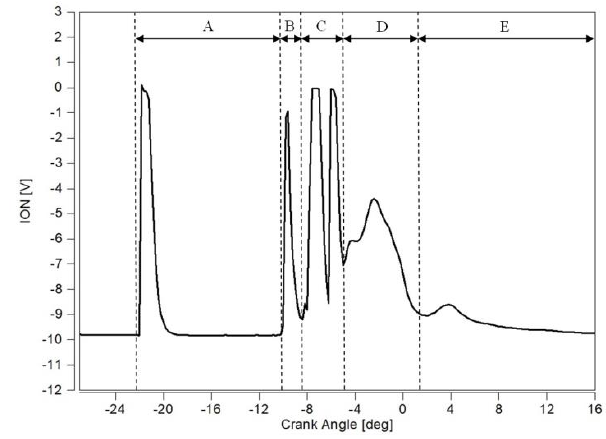
Fig. 1. Real ionization voltage signal with marked phases: A – ignition coil charging phase; B – discharge phase; C – phase of electromagnetic